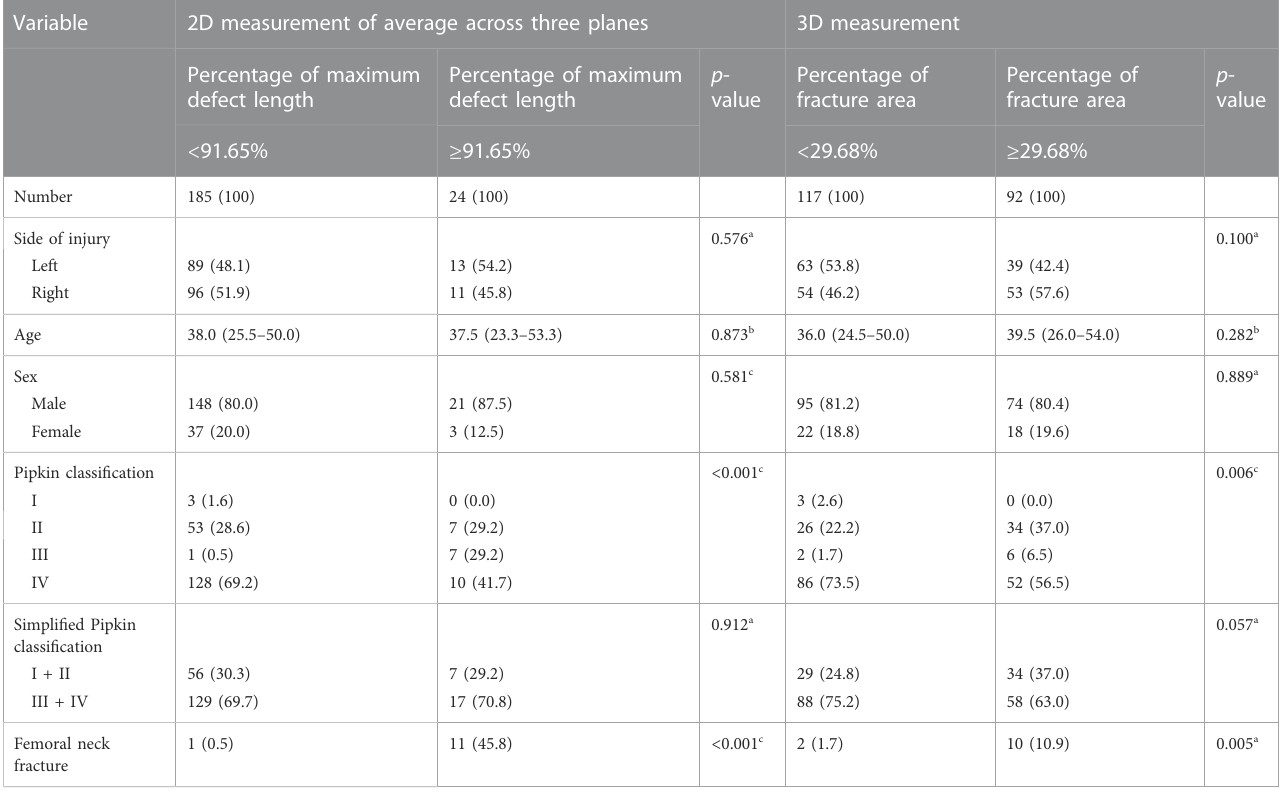
TABLE 5 Data for 209 patients with femoral head fractures.